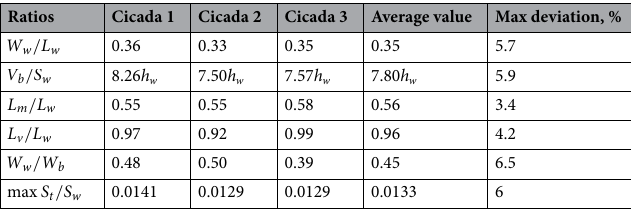
Table 2. Ratios with the close values in the three cicadas